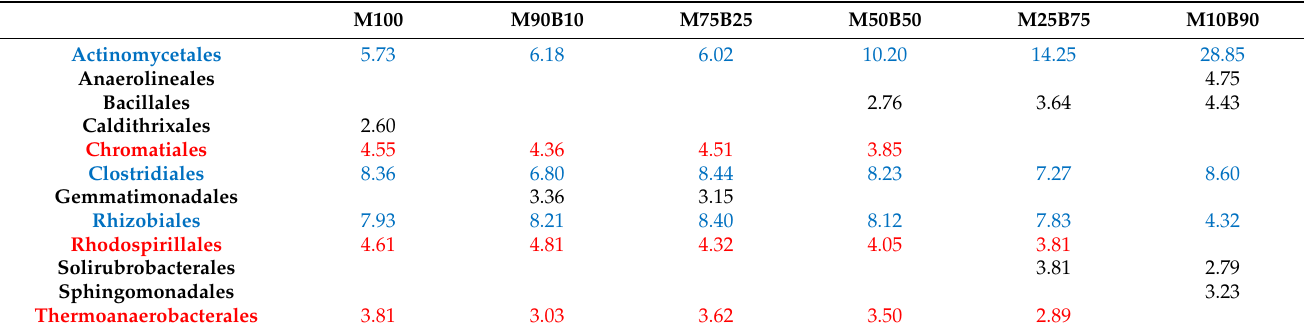
Table 6. Order classification for mud compost (M) blended with biochar (B) by percent of total nucleic acids in the sample metagenome.